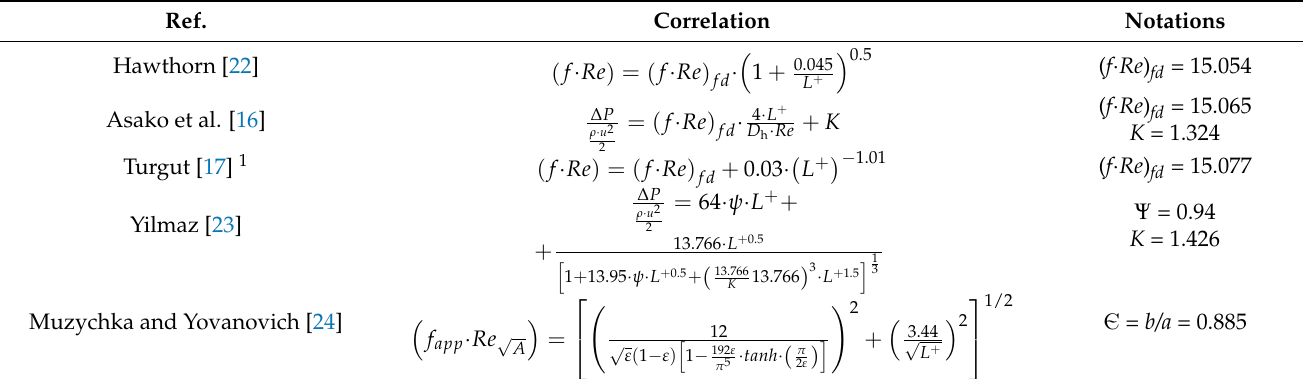
Table 1. Literature models describing the fluid flow through a hexagonal duct. Ref.